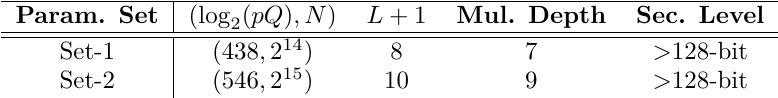
Table 1: Parameter